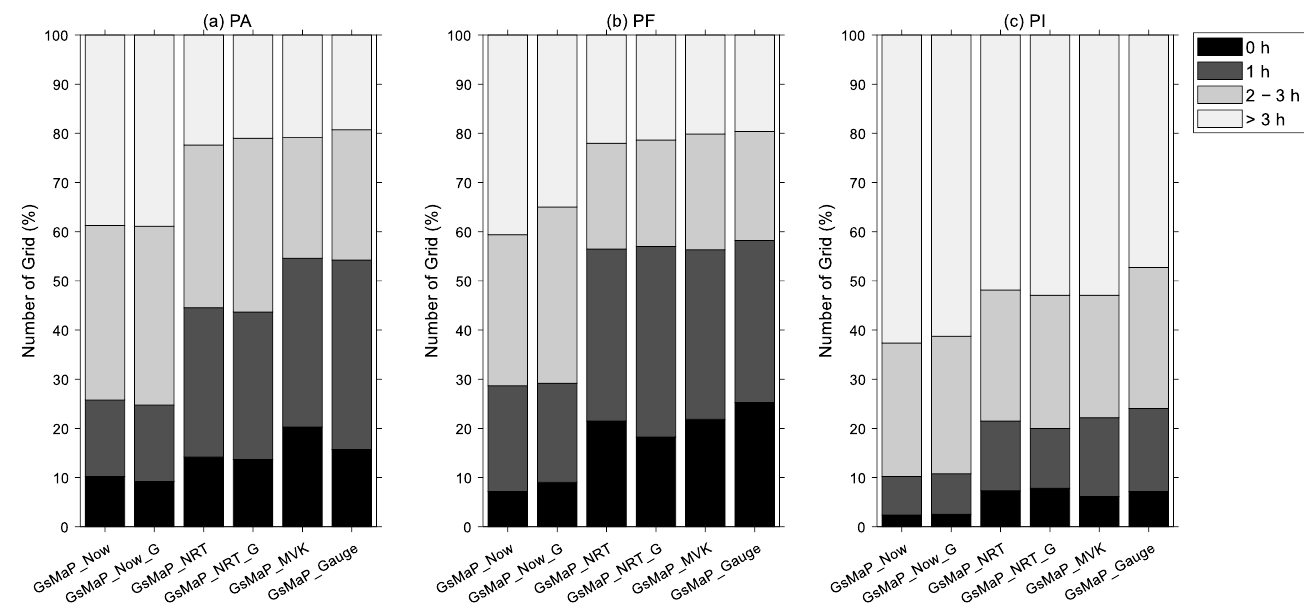
Figure 6. The percentage of stations for several categories of difference in peak time of PA ( a ), PF ( b ), and PI ( c ) from GSMaP and RG.